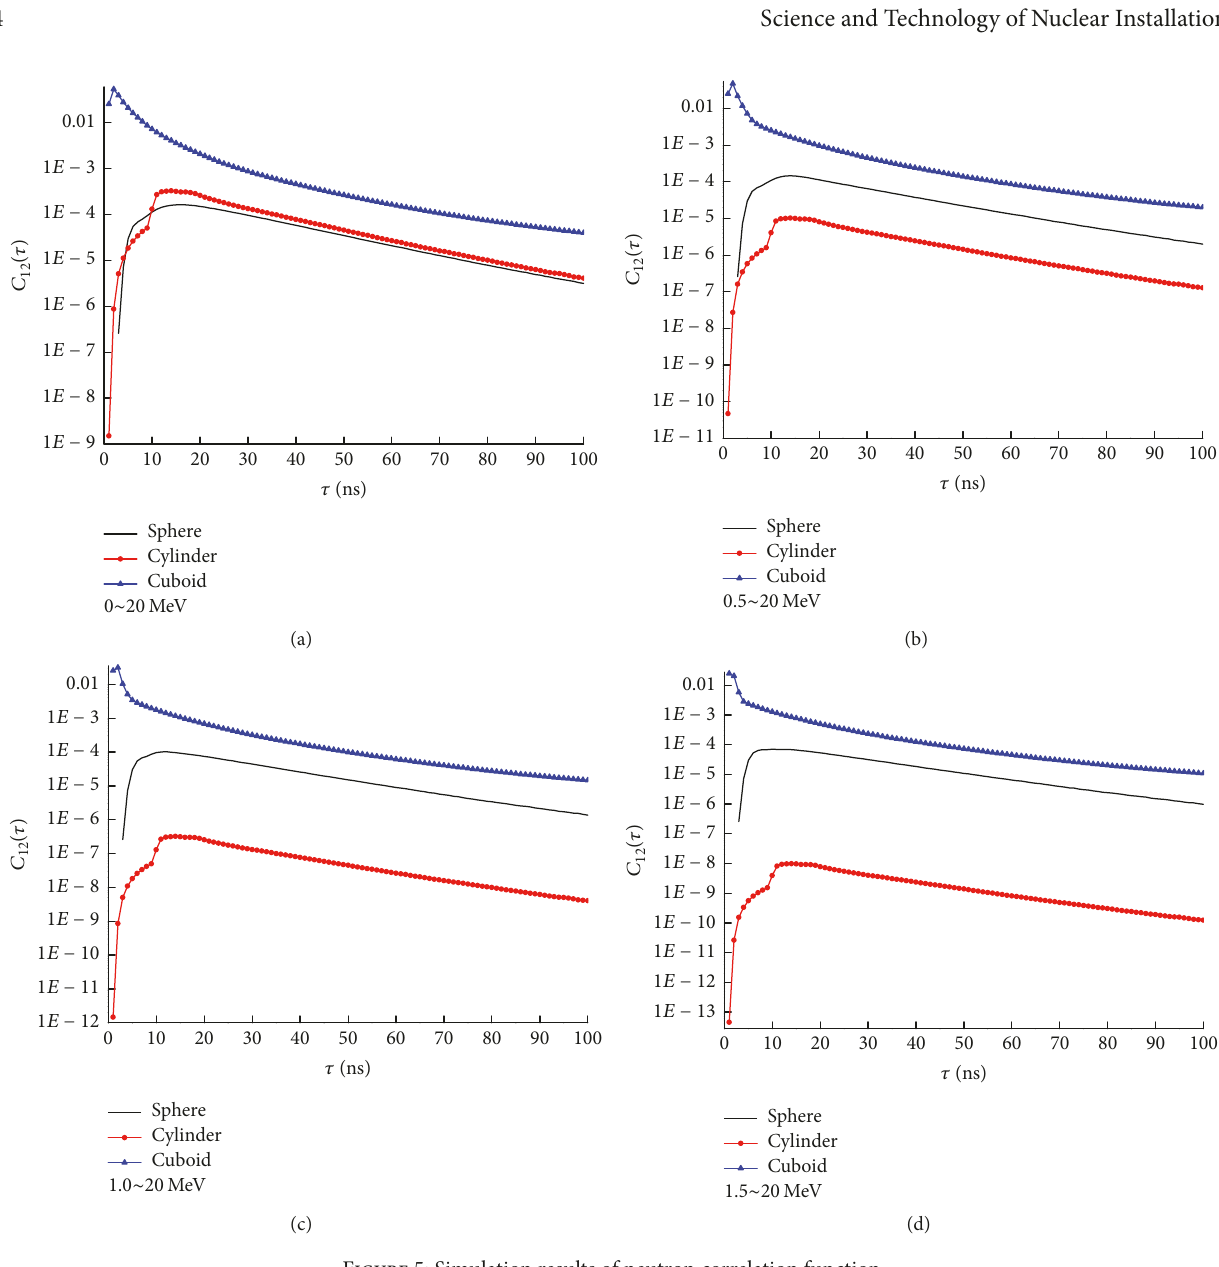
Figure 5: Simulation results of neutron correlation